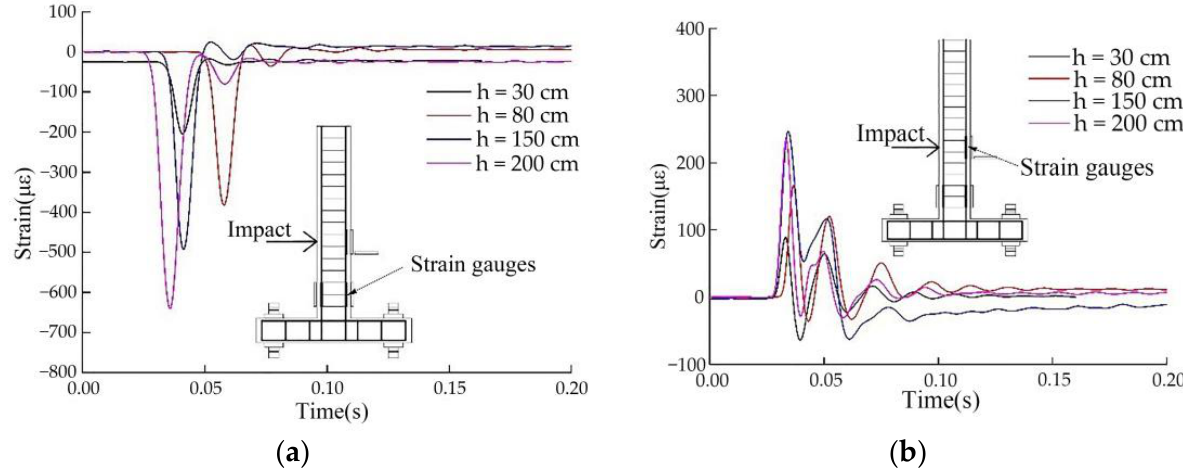
Figure 8. Strain time history of rebar and concrete at the column bottom: ( a ) strain time history of concrete and ( b ) strain time history of rebar.